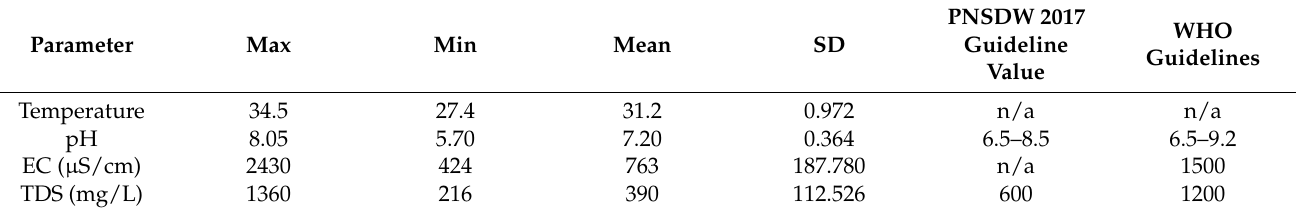
Table 1. Physicochemical properties of surface water.